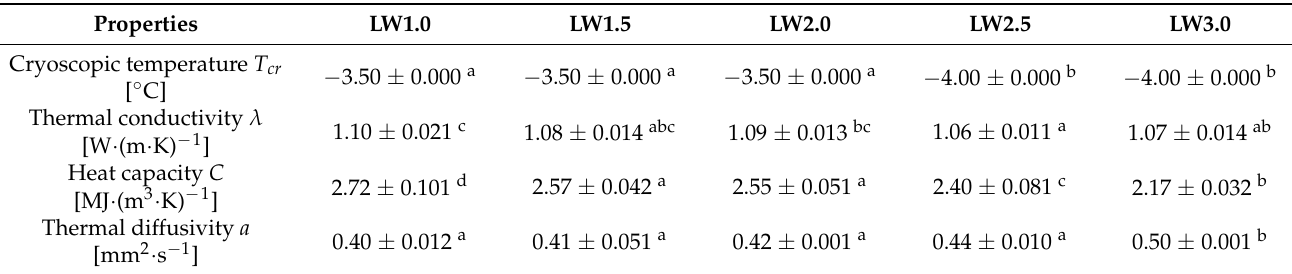
Figure 2. The influence of shear rate on the change in the viscosity of ice cream with MDB . Table 6. Thermophysical properties of the tested ice